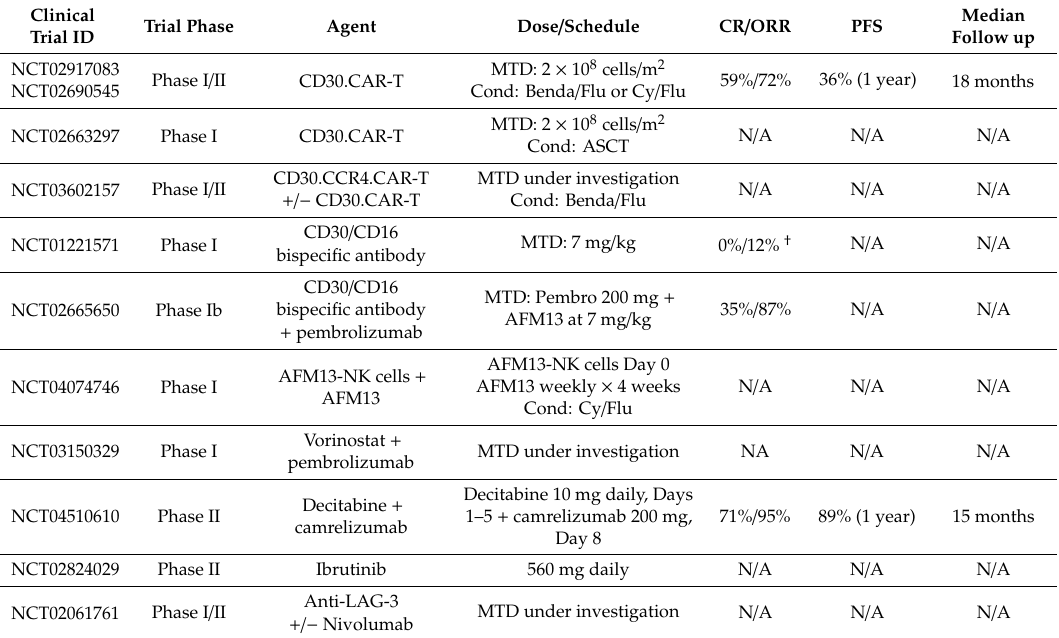
Table 3. Novel investigational approaches for r / r classical Hodgkin